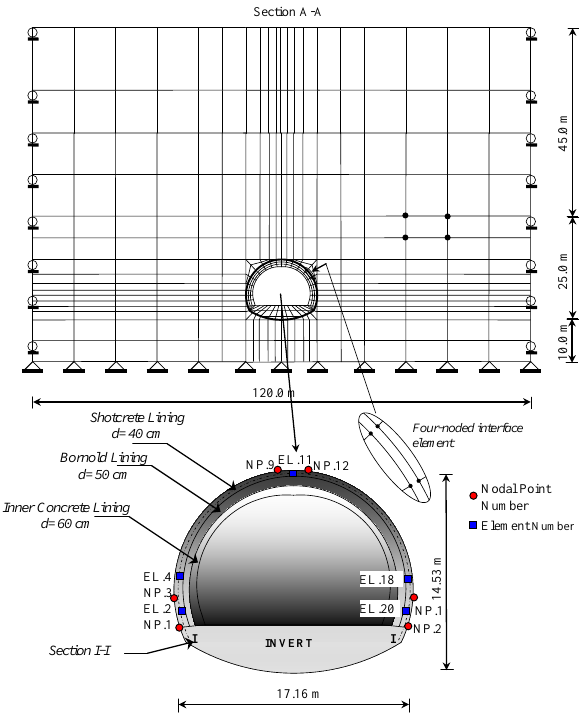
The tunnel-soil deposit interaction model subjected to random earthquake ground motions in Fig.2. Finite element model of the tunnel-soil deposit system and the detail of the Bolu tunnel for A-A the horizontal direction is presented Fig.3. The horizontal input is assumed to travel across the tunnel- Fig. 2. Finite element model of the tunnel-soil deposit system and cross section soil deposit system from the left site to right site with finite velocity of 2000 m/s. First 15 modes and the detail of the Bolu tunnel for A-A cross section. 10% damping ratio for the analyses are considered. Two translational degrees of freedom are assigned to each node and a plane-strain assumption is used in the calculations.